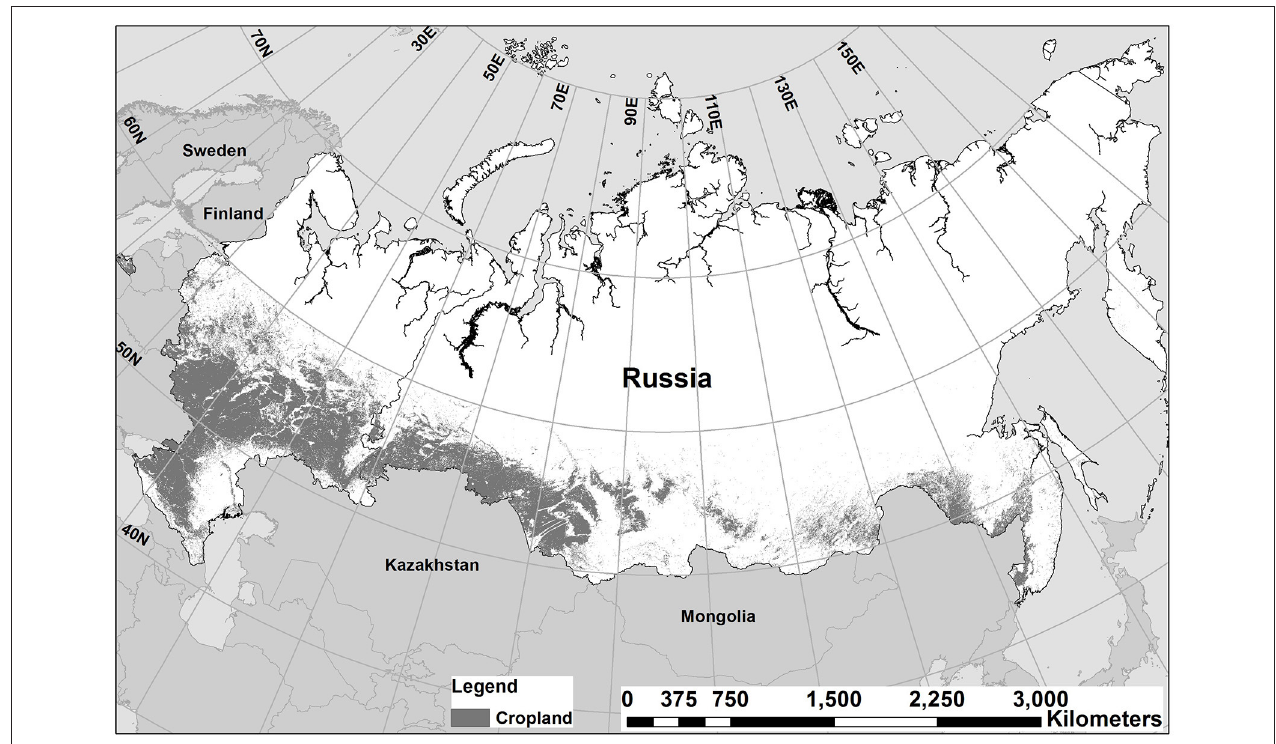
FIGURE 2 | Russian cropland area as defined by the IGBP cropland/ natural vegetation